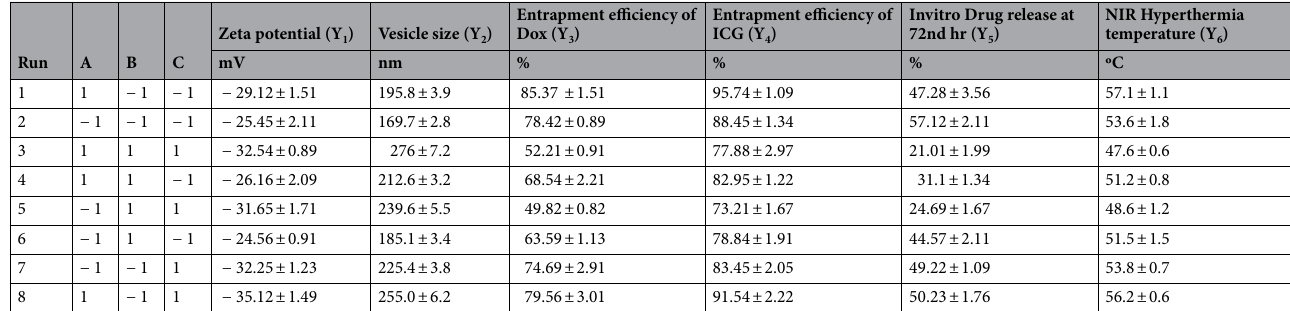
Table 3. Responses of Dox-loaded ICG proniosomal gel-derived niosomes. Data represented as the mean ± SD (n = 3).